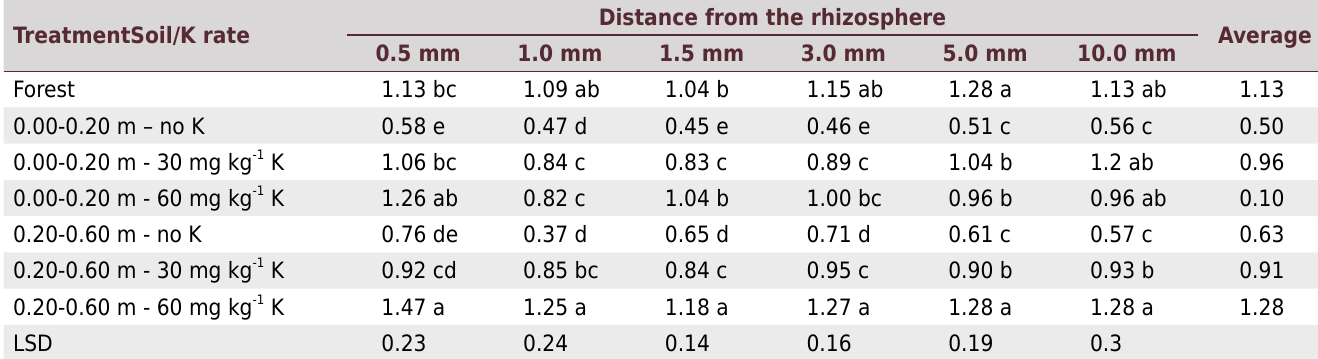
Table 4. Exchangeable K contents in the soils from the forest and from cultivated fields sampled at 0.00-0.20 and 0.20-0.60 m, as affected by K rates. Treatments compared within each distance from the rhizosphere TreatmentSoil/K